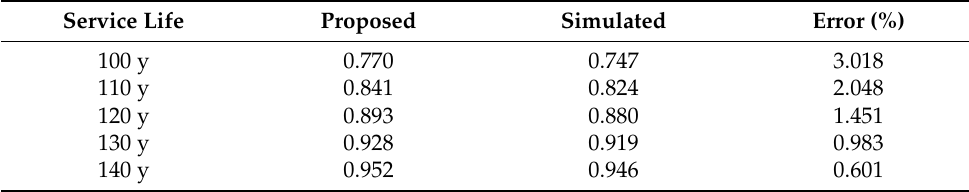
Figure 9. Spatial correlation of T ci with µ ( x 0 ) = 50 mm. Table 6. The failure probabilities of the surface obtained by the proposed and simulation-based methods ( µ ( x 0 ) = 50